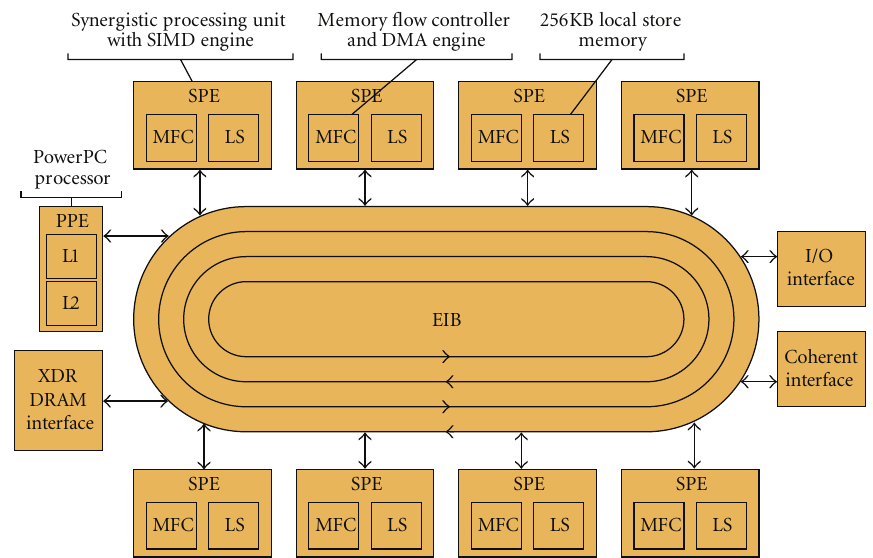
Figure 5: Architecture of Cell BE